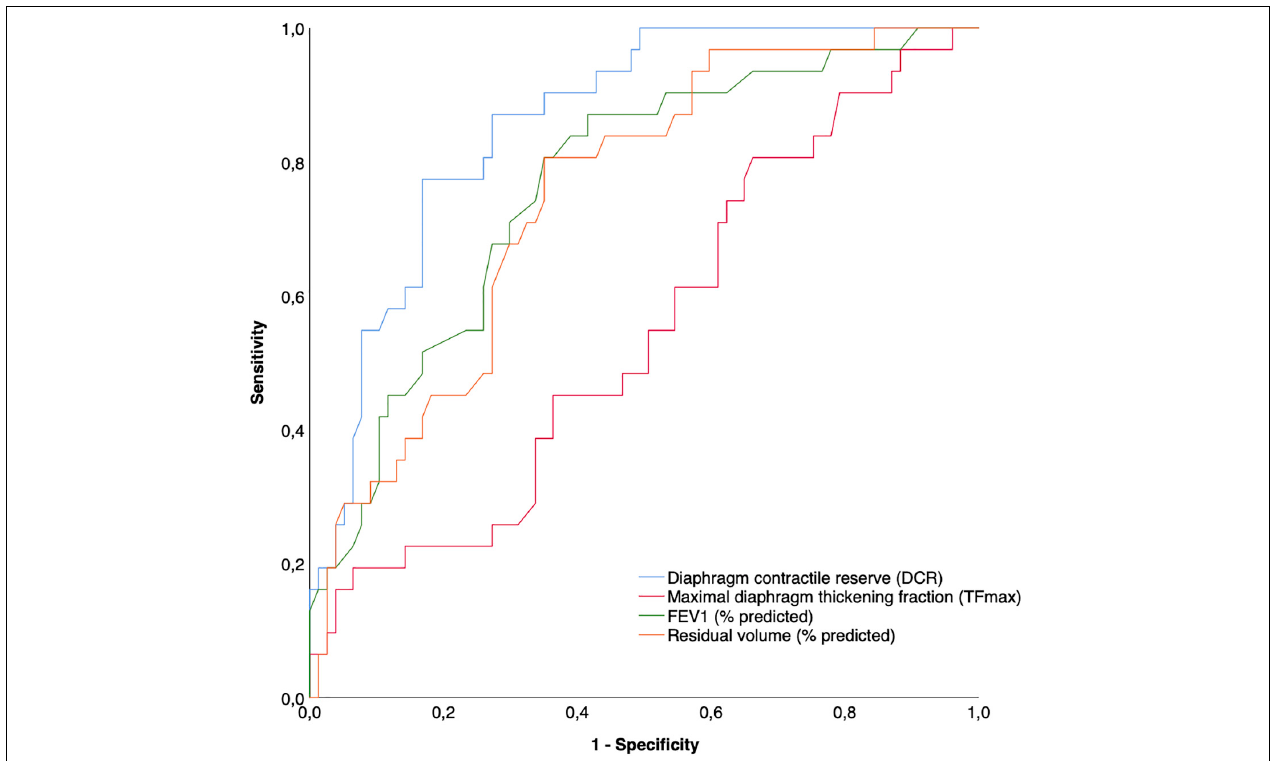
FIGURE 3 | Receiver operating characteristics curves comparing different ultrasound and physiological variables in the prediction of the presence of a higher ( > 2 on mMRC scale) dyspnea